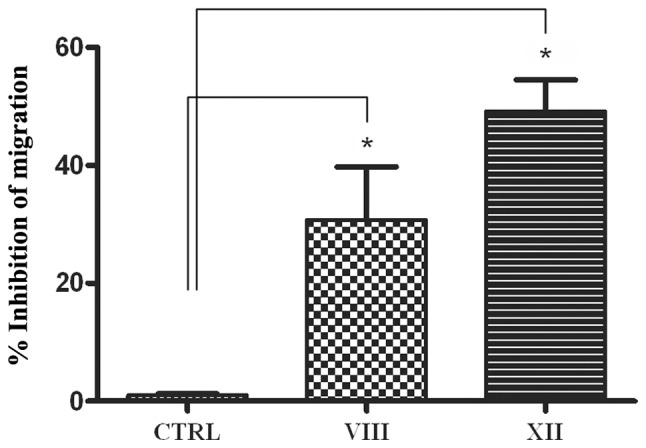
Effect of AKT Inhibitors on MSC migration. MSC migration was examined after AKTi VIII and XII treatment by transwell migration assay. *p<0.05. Error bars indicate SD.